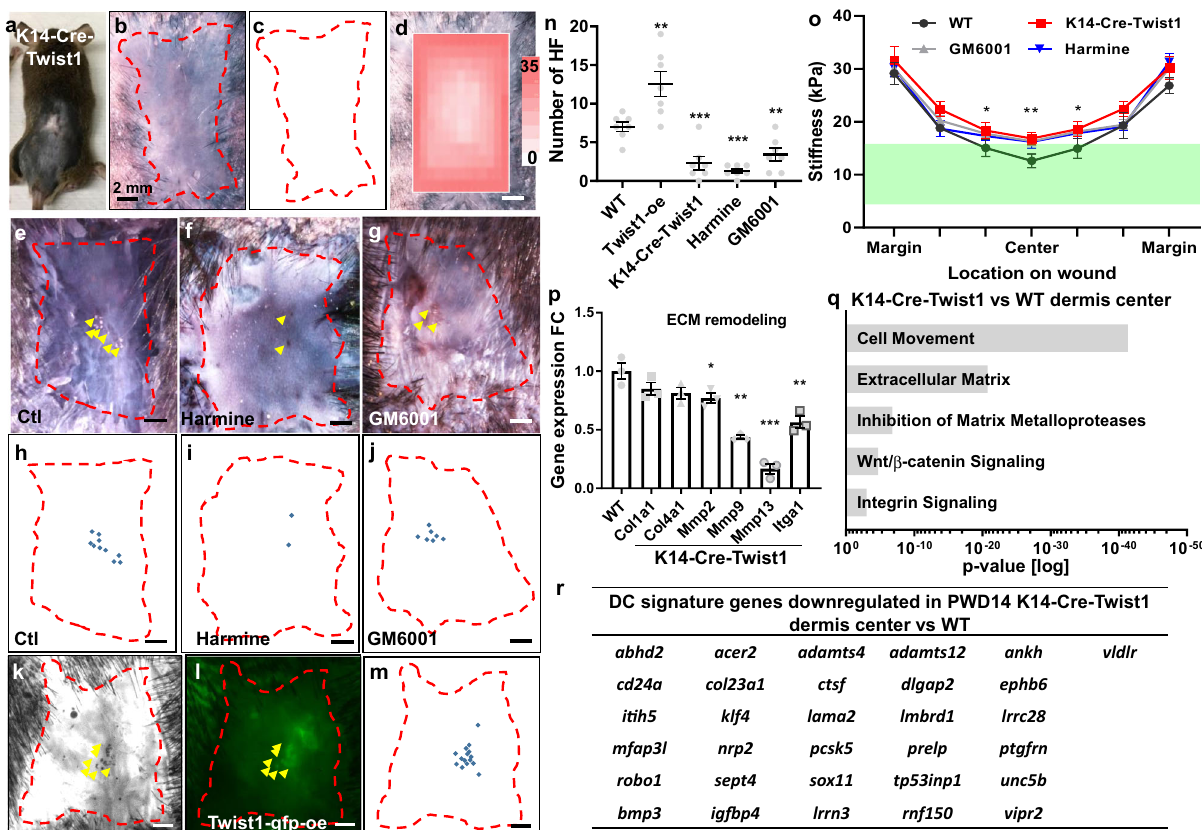
Fig. 5 Epidermal Twist1 regulates both epidermal and dermal cell behavior and tissue stiffness towards hair primordia formation in WIHN. a A K14- Cre-Twist1 mouse with a PWD28 wound. b AP staining of a K14-Cre-Twist1 PWD28 wound. c , Schematic diagram of b . d Stiffness heatmap of PWD14 K14-Cre-Twist1 wound overlaying on the wound photo. e – g AP staining of control (Ctl), and Harmine and GM6001 treated wounds on PWD28. h – j Schematic diagrams of e – g , respectively. j Photo of PWD28 wound transfected with Twist1-overexpressing lentivirus. k bright fi eld and l fl uorescence image of GFP-tagged-Twist1 overexpressing (oe) virus in the PWD28 wound, colocalizing with hair follicles. m Schematic diagram of k and l . n Dot plot showing the resultant hair follicle number in wild type, K14-Cre-Twist1, Harmine-treated, GM6001-treated and Twist1-overexpressing (oe) virus treated PWD28 wounds. n = 7 biologically independent animals. Data are presented as mean values± SEM. All comparisons made to WT. Twist1-oe: p = 0.0074, K14-Cre-Twist1: p = 0.0008, Harmine: p < 0.0001, GM6001: 0.0044. Unpaired two-sided t -test. o Changes in wound stiffness upon different perturbations. K14-Cre-Twist1, GM6001 and Harmine treatments all signi fi cantly increased the stiffness of the wound center region, marked by asterisks. Green bar: 5 – 15 kPa morphogenetic range. n = 5 biologically independent animals. Data are presented as mean values ± SEM. All comparisons made to WT of respective location on wound. Center: K14-Cre-Twist1, p = 0.0006; GM6001, p = 0.0006; Harmine, p = 0.0018. Center-left: K14-Cre-Twist1, p = 0.01115; GM6001, p = 0.0137; Harmine, p = 0.0214. Center-right: K14-Cre-Twist1, p = 0.0083; GM6001, p = 0.006; Harmine, p = 0.0159. Unpaired two- sided t -test. p qPCR analysis: ECM remodeling related-gene expression fold change (FC) of wild type epidermis wound center vs K14-Cre-Twist1 wound center. n = 3 biologically independent samples. Data are presented as mean values ± SEM. All comparisons made to WT. Mmp2 , p = 0.0483; Mmp9 , p = 0.0014; Mmp13 , p = 0.0005; Itga1 , p = 0.0071. Unpaired two-sided t -test. q PWD14 wild type vs K14-Cre-Twist1 dermis wound center RNA-seq analysis identi fi es signi fi cantly enriched pathway affected by K14-Cre-Twist1 knockout. r Dermal condensate (DC) signature genes downregulated in PWD14 K14- Cre-Twist1 dermis wound center. Red dotted line: wound boarder. Yellow arrow: hair follicle. Harmine: Twist1 inhibitor. GM6001: pan-MMP inhibitor. Ctl: control. The images in a – m represent 6 out of 7 experiments